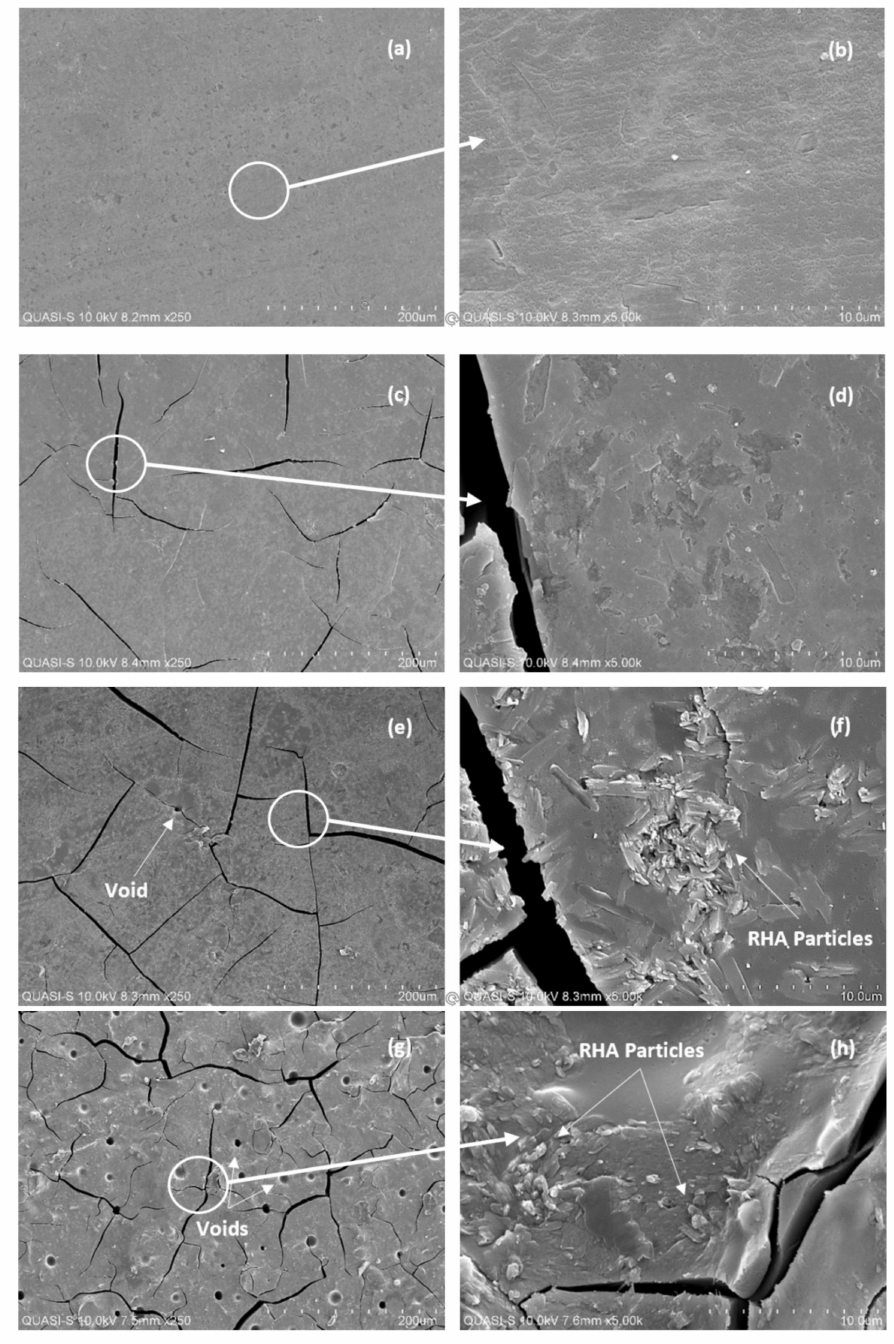
Figure 9. The SEM micrographs for sample S28—ductile ( a , b ), S5—semi-ductile ( c , d ), S7—semi-brittle ( e , f ), and S23—brittle ( g , h